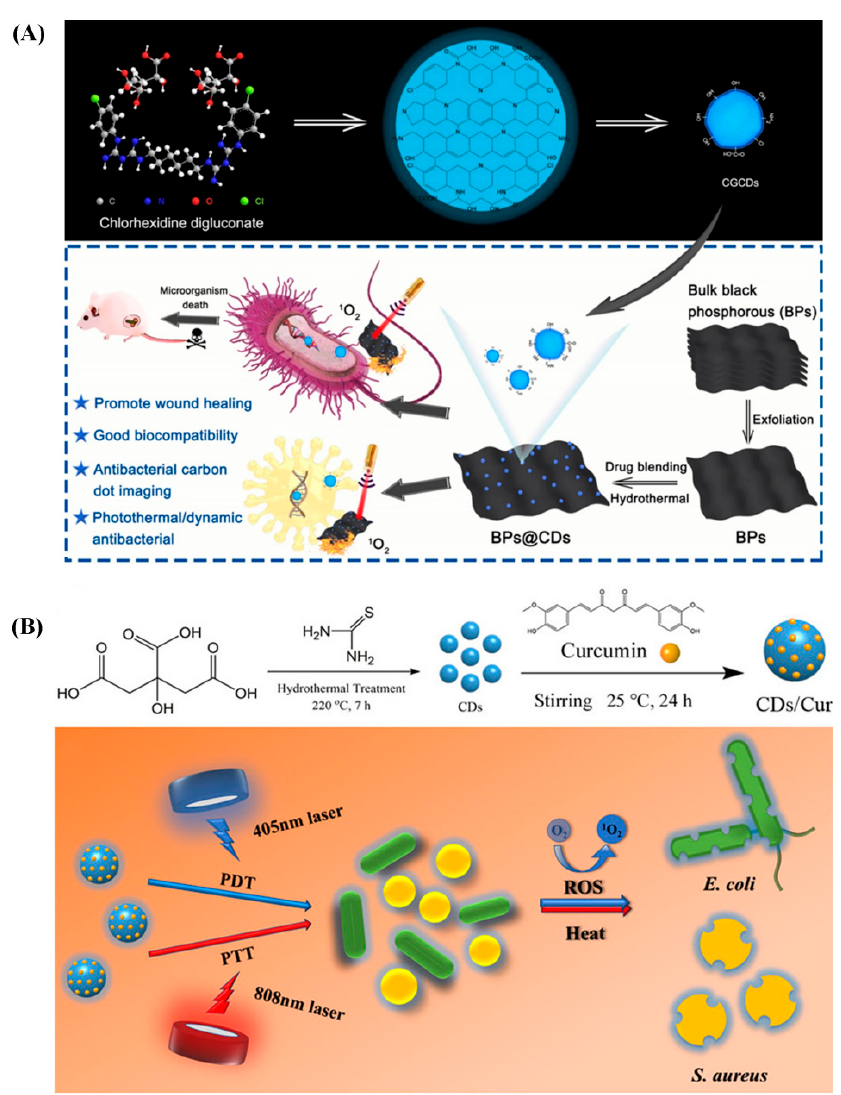
Figure 5. ( A ) Schematic diagram illustrating the preparation of BPs@CDs for eliminating bacteria. Reproduced with permission from [91]. Copyright 2021, Springer Nature. ( B ) Scheme illustrating the preparation of the CDs/Cur nanocomposite and its PDT- and PTT-mediated antimicrobial performance. Reproduced with permission from [90]. Copyright 2021, American Chemical Society.